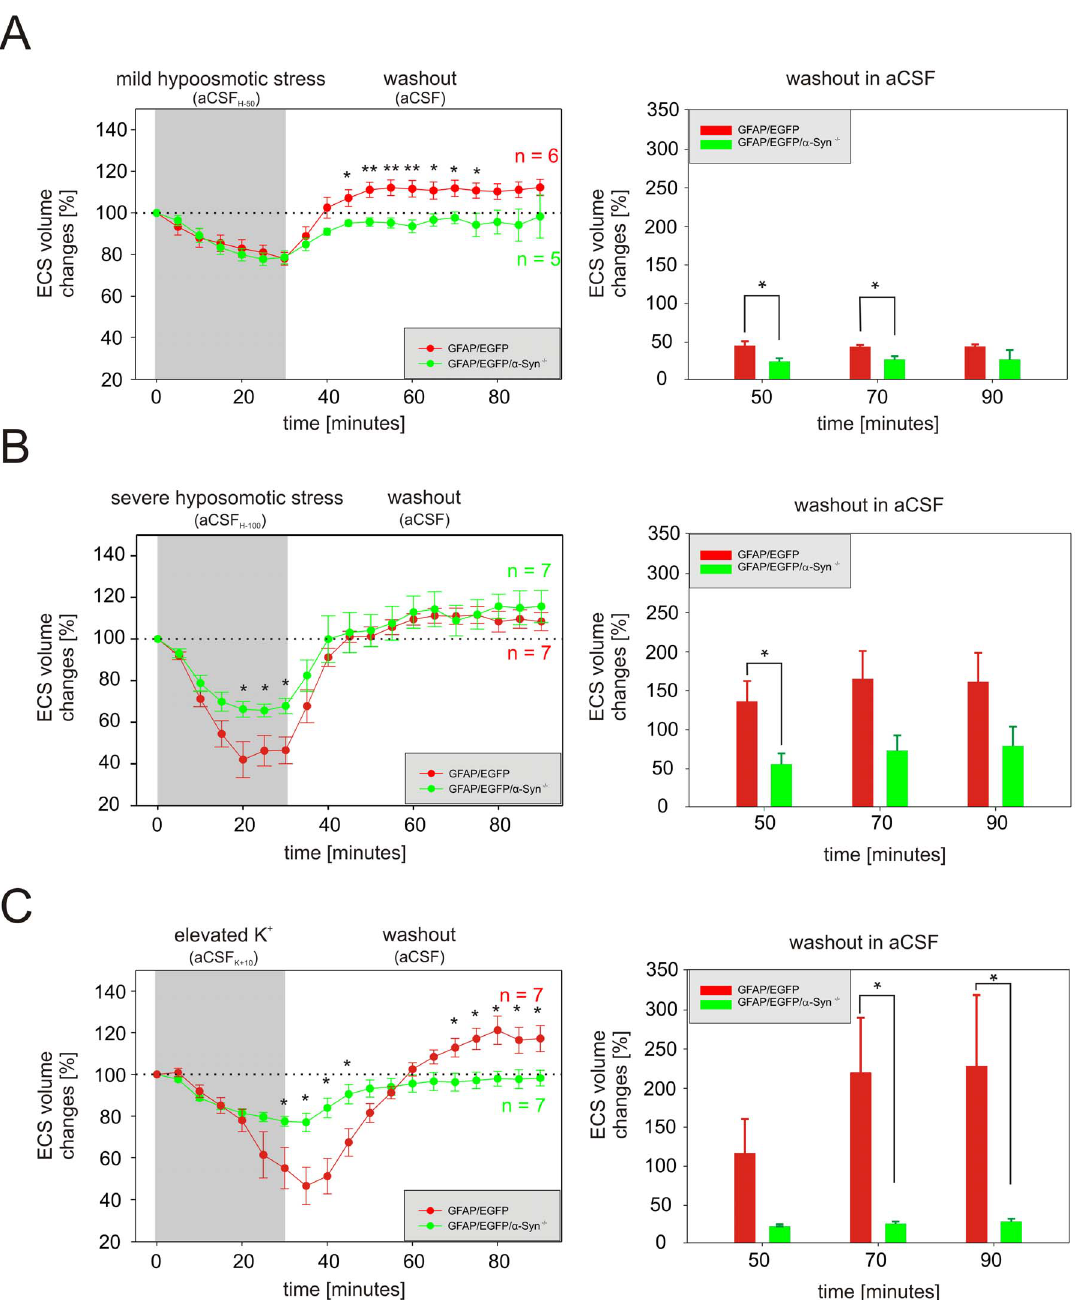
Figure 2. The effect of hypotonic stress or elevated K + on the ECS volume in situ . The left side: The control values of all experiments were set to 100%, and the relative changes of the values of the extracellular volume fraction a were calculated at 5 min intervals during a 30 min application and a subsequent 60 min washout of mild ( A ) or severe ( B ) hypotonic stress or 10 mM K + ( C ). Each data point represents mean ¡ S.E.M. The right side: volume regulation during washout at 20 min intervals is expressed as changes in the values reached in the 30 th minute of application, set as 0%. Asterisks indicate significant (*, p , 0.05) and very significant (**, p , 0.01) differences between GFAP/EGFP and GFAP/EGFP/ a -Syn 2 / 2 mice.